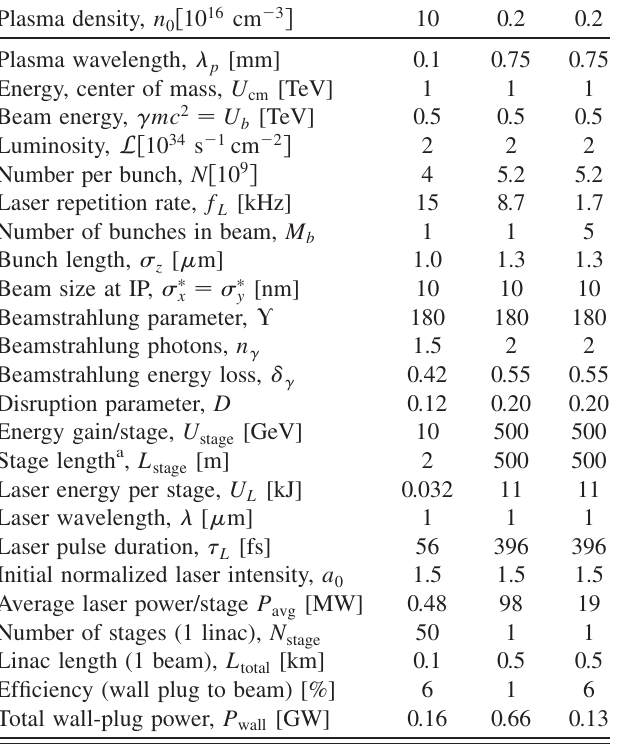
TABLE IV. Three example parameter sets for a 1 TeV laser- plasma linear collider operating at plasma densities n 10 17 cm (cid:1) 3 and 2 (cid:7) 10 15 cm (cid:1) 3 with the beamstrahlung con- straint n (cid:4) (cid:9) 2